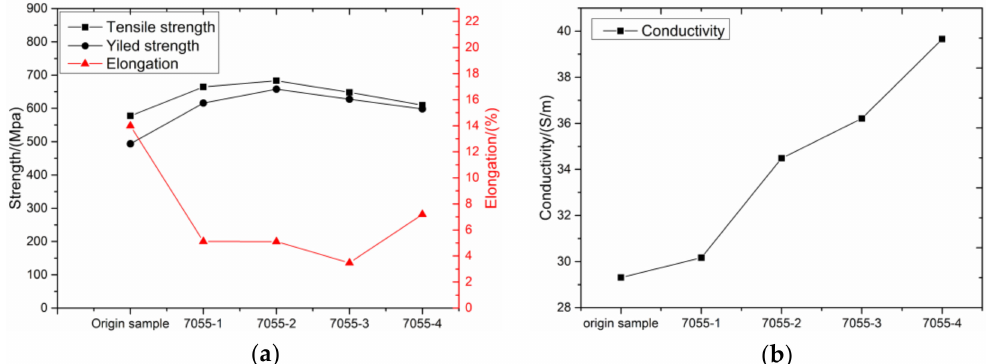
Figure 5. Mechanical properties of the samples: ( a ) strength and elongation; ( b )